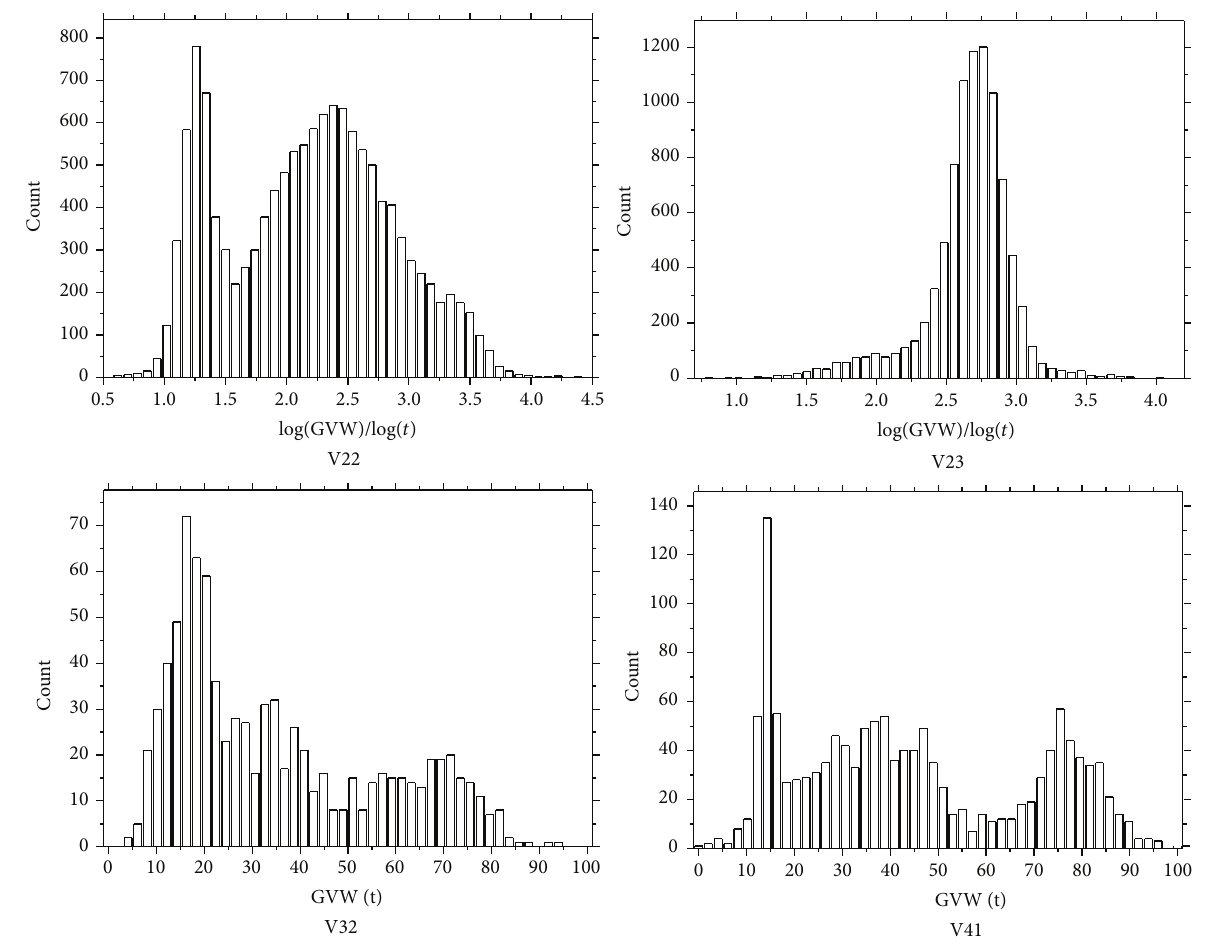
Figure 13: GVW probability distributions for simulated traffic flow.